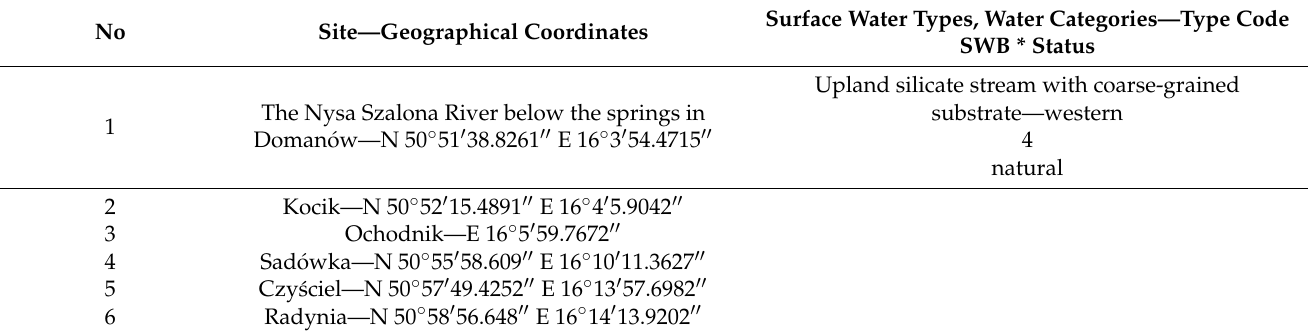
Table 2. Research sites—the Nysa Szalona River and its tributaries above the Słup dam reservoir